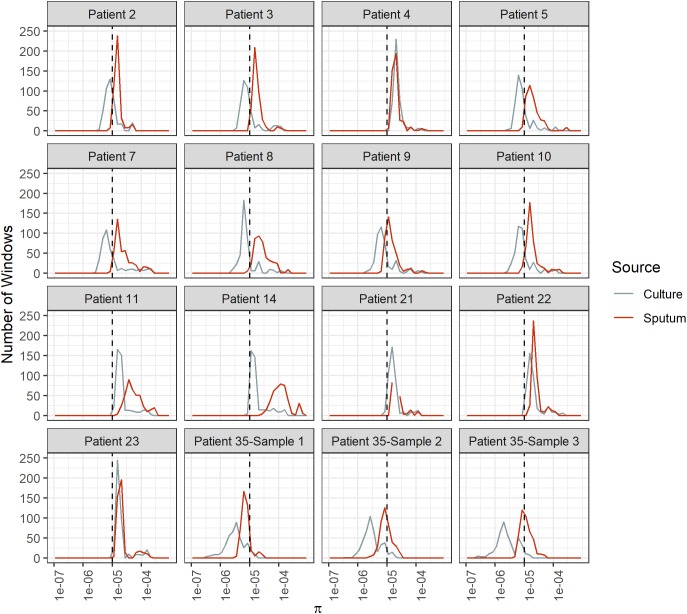
Bacterial diversity across genome windows in sputum and culture samples. Frequency (y-axis) of nucleotide diversity (π, x-axis) in sliding windows across the genome (windows = 100 Kb, step-size = 10 Kb). Diversity varies among patients as well as among samples from the same patient, as shown by the differences in the shapes of these distributions. Sputum samples exhibit more variability among patients, and diversity is generally higher than it is for culture samples. Sputum and culture in red and gray, respectively. Dotted line at π = 1e-5.